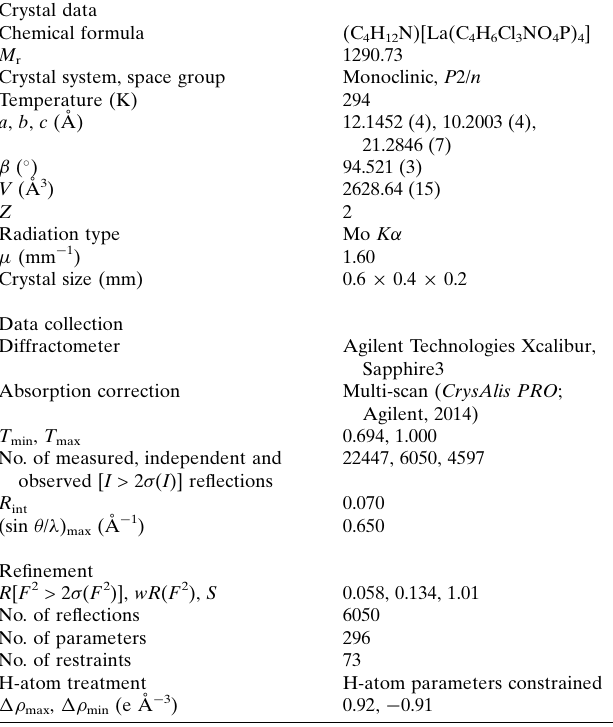
Figure 3 The Hirshfeld surface mapped over d norm and two-dimensional fingerprint plots for the Cl (cid:2)(cid:2)(cid:2) H/H (cid:2)(cid:2)(cid:2) Cl (50.7%), H (cid:2)(cid:2)(cid:2) H (20.8%), O (cid:2)(cid:2)(cid:2) H/H (cid:2)(cid:2)(cid:2) O (13.6%), Cl (cid:2)(cid:2)(cid:2) Cl (11.6%) and N (cid:2)(cid:2)(cid:2) H/H (cid:2)(cid:2)(cid:2) N (3.1%) interactions in NMe 4 [La L 4